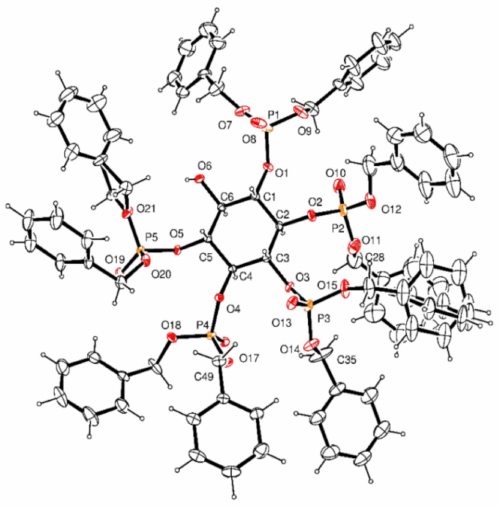
Figure 7. ORTEP diagram of compound 16 at 30% probability